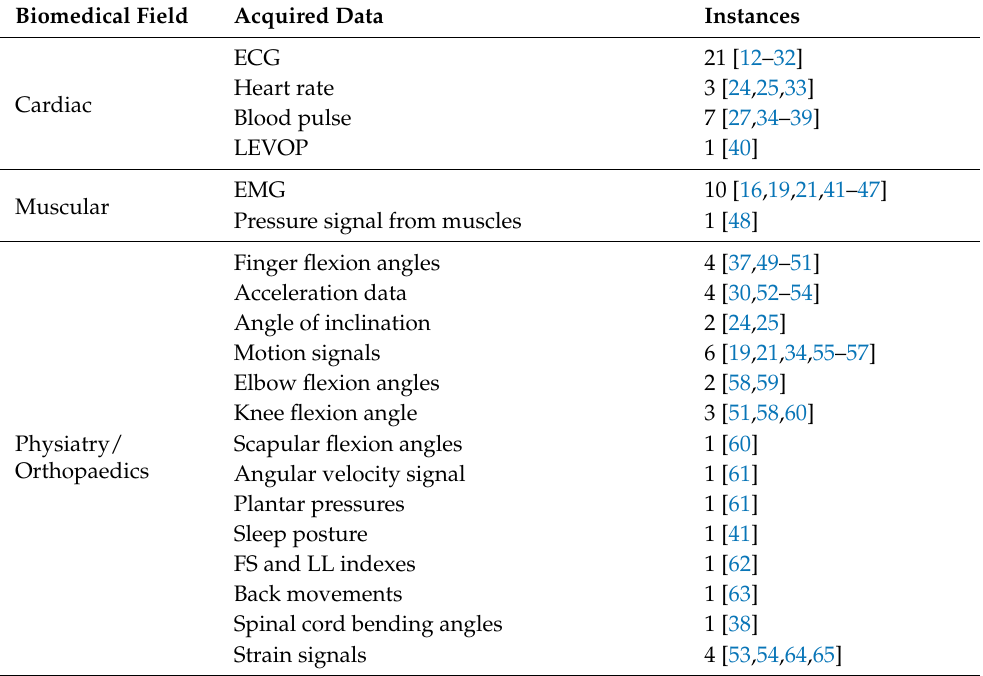
Table 1. Number of instances for each acquired data, data type, and potential diagnosis combined with related references.